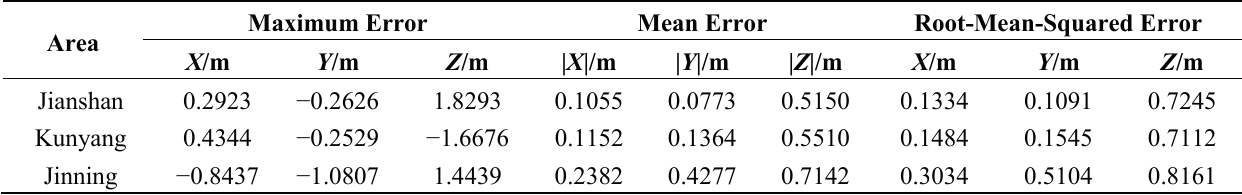
Table 7. Results of the accuracy assessment of the generated DSMs and DOMs in respect to GCPs from GPS in the study areas.